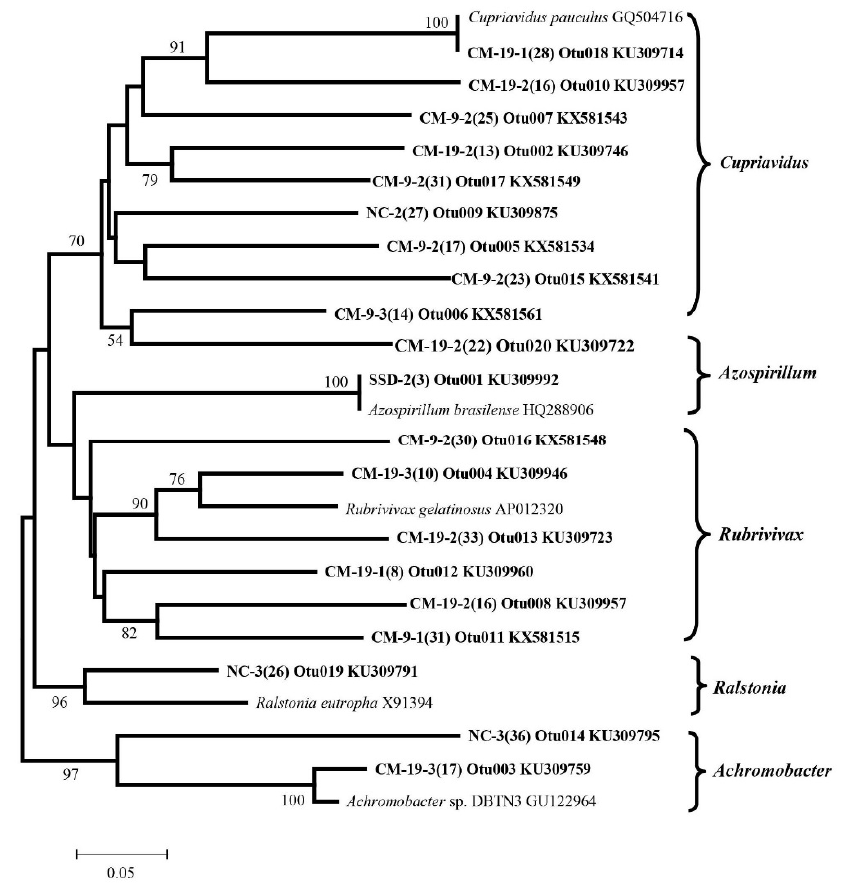
Figure 3. Phylogenetic distribution of 24 representative OTUs of the nirS gene. Tree was constructed by the sequences obtained from sand dune sampling sites and additional their closely matched sequences from GenBank.